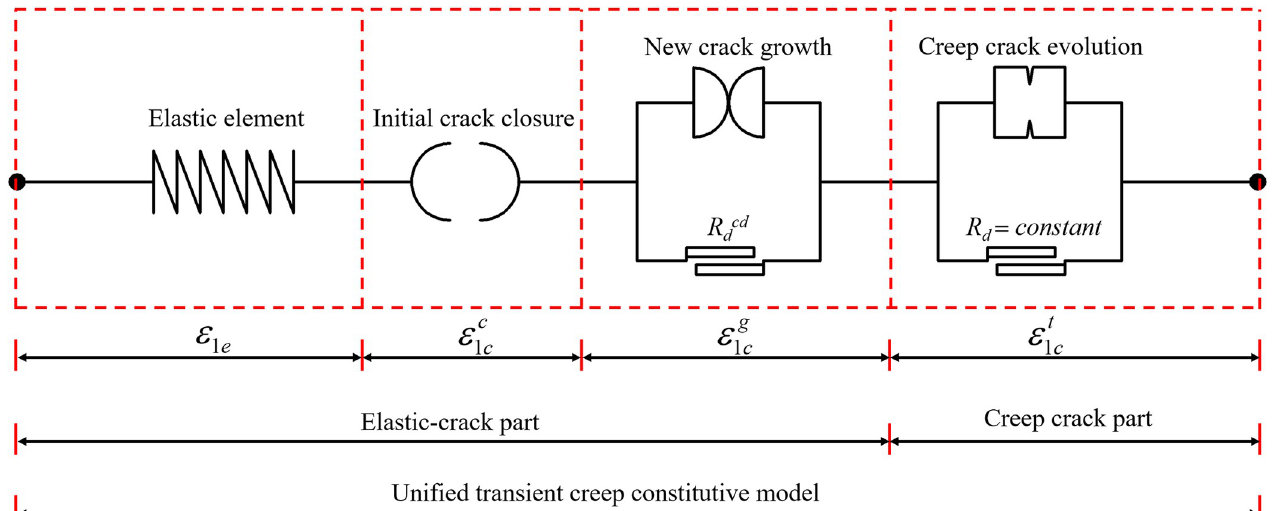
Fig 19. Unified transient creep constitutive model based on crack evolution.